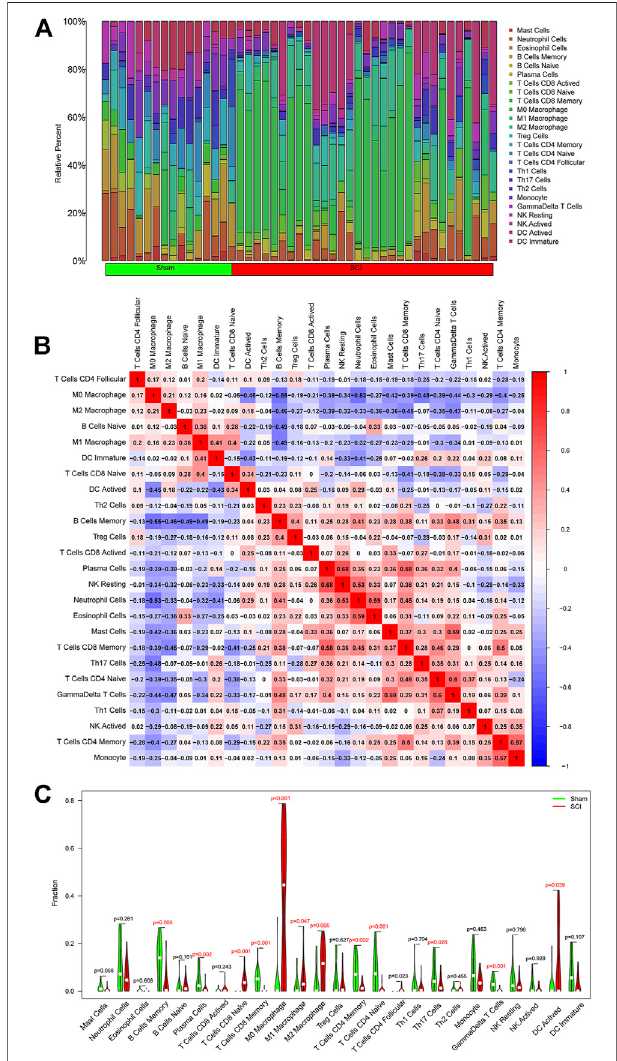
FIGURE 6 | Assessment and visualization of immune cell in fi ltration. (A) The relative percentage of 25 types of immune cells. (B) Heatmap exhibited the correlation of 25 types of immune cells. Both horizontal and vertical axes demonstrate immunecellsubtypes. (C) The violindiagram displayed the ratio of 25 types of immune cells. The red represents the SCI group, and the green represents the sham group.